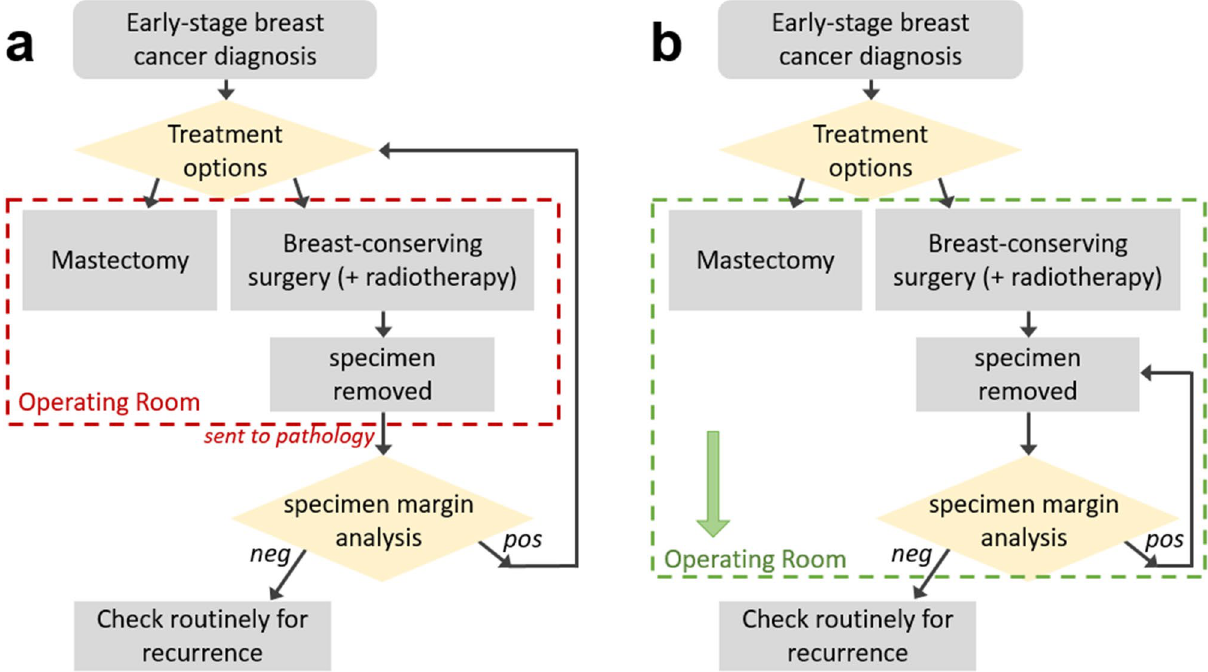
Figure 1. Flowchart of treatment options for early stage breast cancer. (a) In current clinical practice, the lumpectomy specimen is removed; after completion of the surgery, the specimen is sent to pathology for analysis. Positive margin results require additional surgeries, either a second lumpectomy or conversion to mastectomy. In contrast, (b) shows an improved workflow, in which the specimen margin analysis